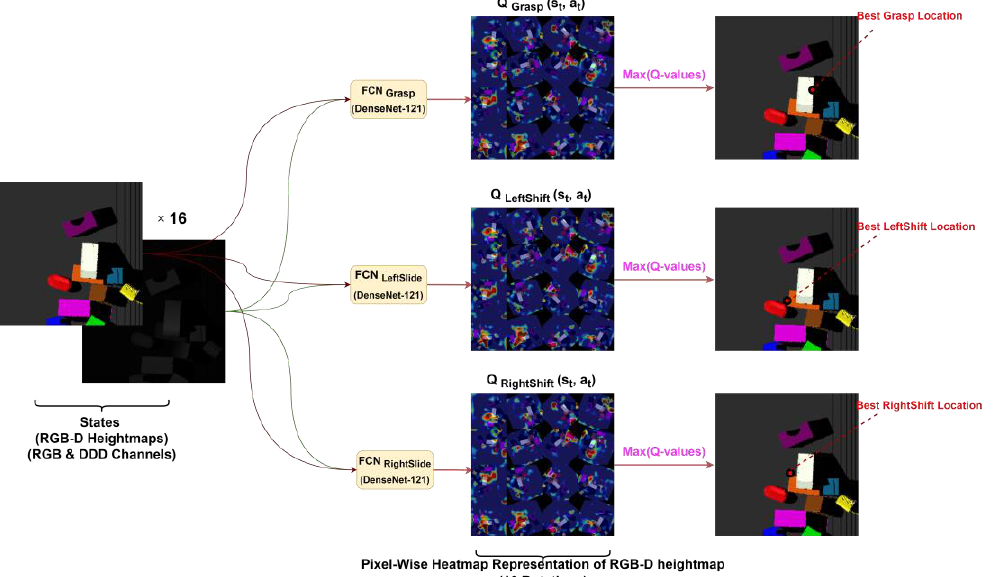
Figure 8. The flow of the whole approach is shown in this figure. RGB-D heightmaps comprising RGB and DDD channels generated as state representations are rotated by 22.5 degrees and all 16 rotations are fed to all three FCNs { FCN Grasp , FCN LeftSlide , FCN RightSlide } based on DenseNet-121 architecture. A pixel-wise map of affordances is generated by each FCN against each rotation of RGB-D heightmap. This map constitutes Q-values, shown in the heatmap format. The maximum Q-value is chosen out of all 48 pixel-wise maps for relevant action to be performed.